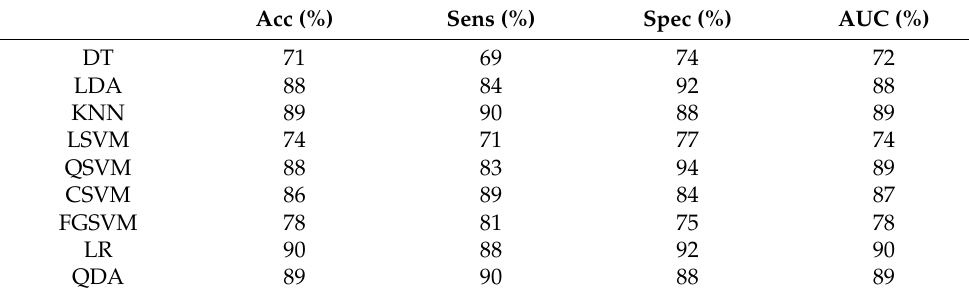
Table 11. Results for the LSDL for Dataset 3.